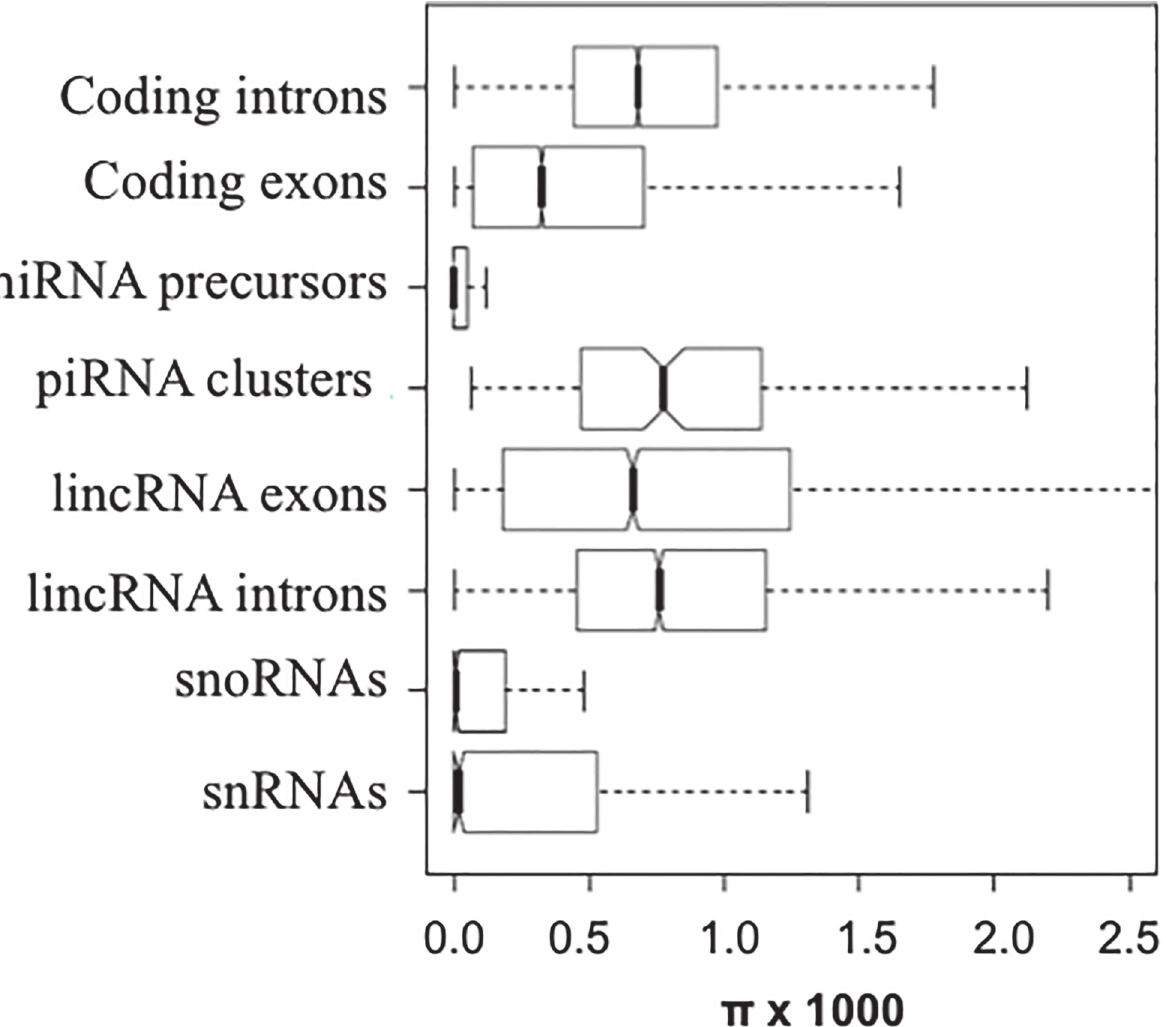
Fig 5. Boxplots of the nucleotide diversity ( π ) in different classes of non-coding RNAs. For comparison, the diversities in pseudogenes, coding sequences, and introns of protein-coding regions are also